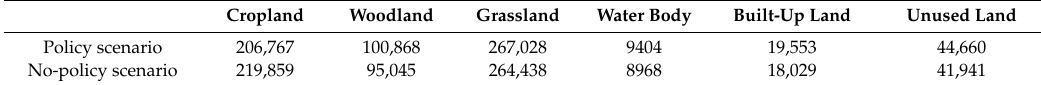
Table 3. The areas of each type of land cover in 2020 under two scenarios (Unit: km 2